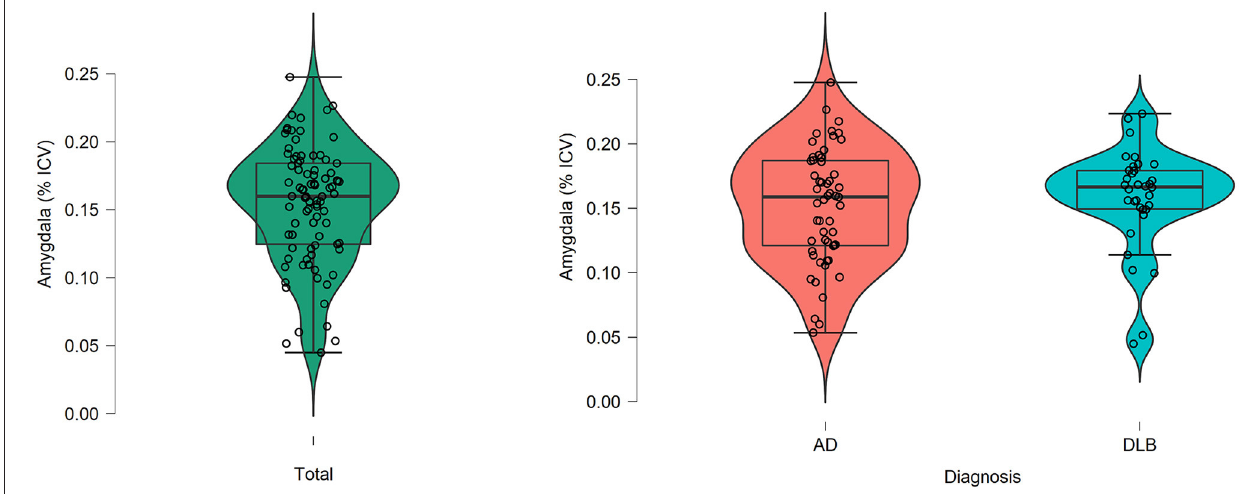
FIGURE 2 | Amygdala volumes after normalization for total intracranial volume in the total sample as well as the AD and DLB groups. Intracranial volume-normalized amygdala (i.e., [Total amygdala volume in mm 3 /total intracranial volume in mm 3 ] * 100%). AD, Alzheimer’s disease; DLB, Dementia with Lewy bodies; ICV, Total intracranial volume in mm 3